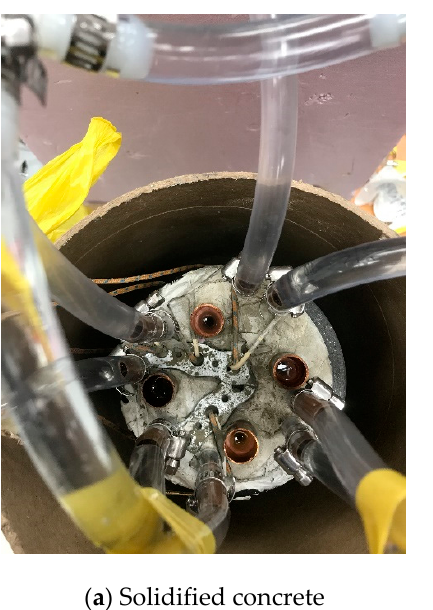
7 of 22 Figure 4. Symmetry lines and thermocouples locations.